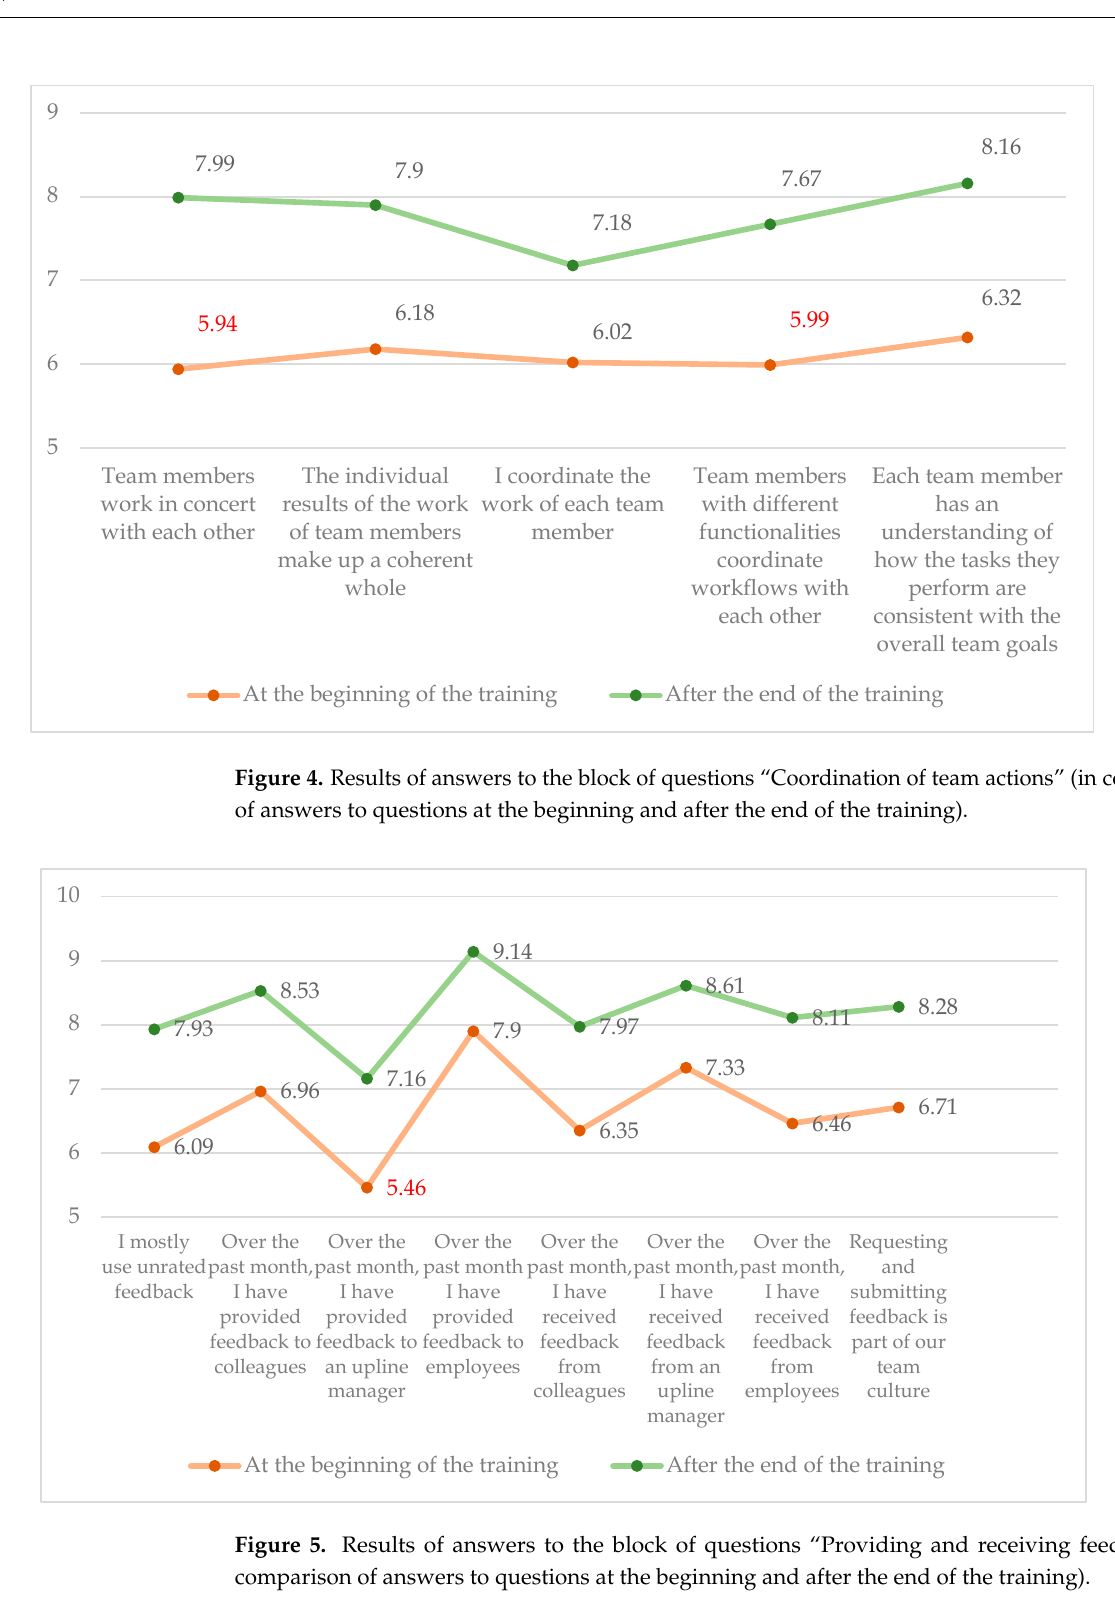
Figure 6. Results of answers to the block of questions “Building trust” (in comparison of answers to questions at the beginning and after the end of the training).